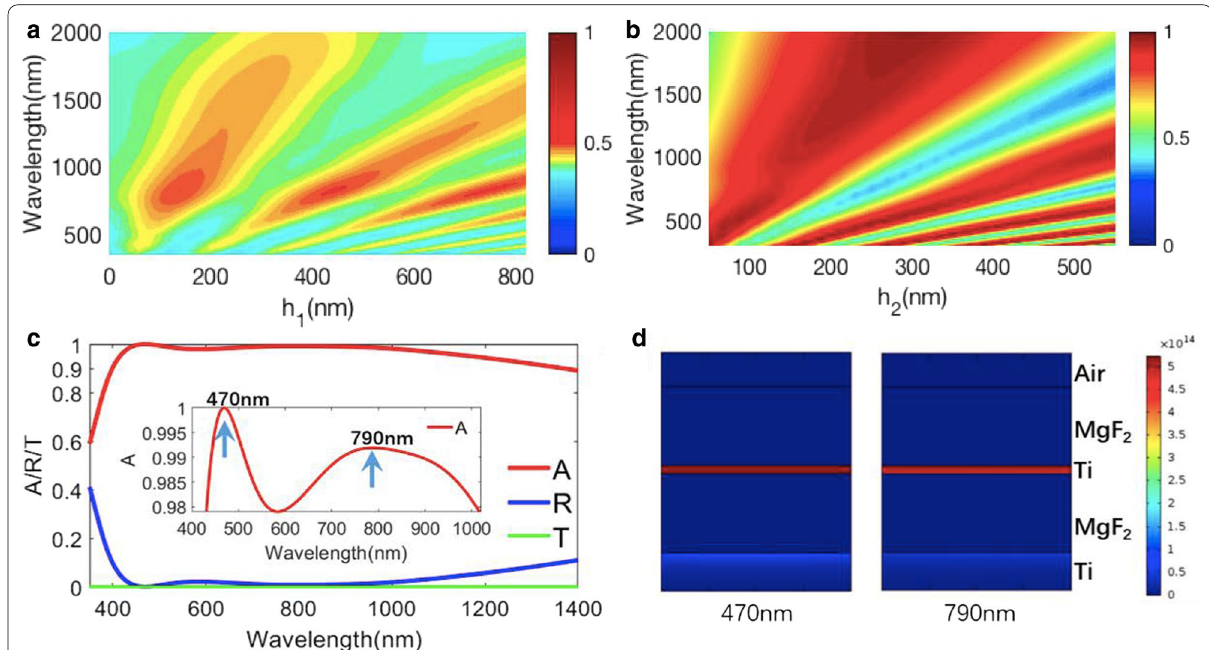
Fig. 2 a Simulated absorption spectra of the structure of MgF 2 /Ti/MgF 2 layers with different h 1 . b Simulated absorption spectra of the the structure of Ti/MgF 2 /Ti layers with different h 2 . c Simulated absorption/transmission/reflection spectra of the metasurface structure consisting of MgF 2 /Ti/ MgF 2 /Ti layers on a substrate. d Power dissipation density calculations for the structure at the wavelengths of two absorption